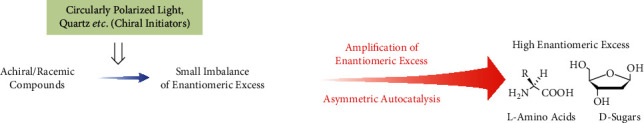
Proposed asymmetric autocatalysis-assisted route to homochirality. Reprinted from Ref. [20] (https://pubs.acs.org/doi/abs/10.1021/ar5003208). Copyright 2014 American Chemical Society; further permissions related to the material excerpted should be directed to the ACS.